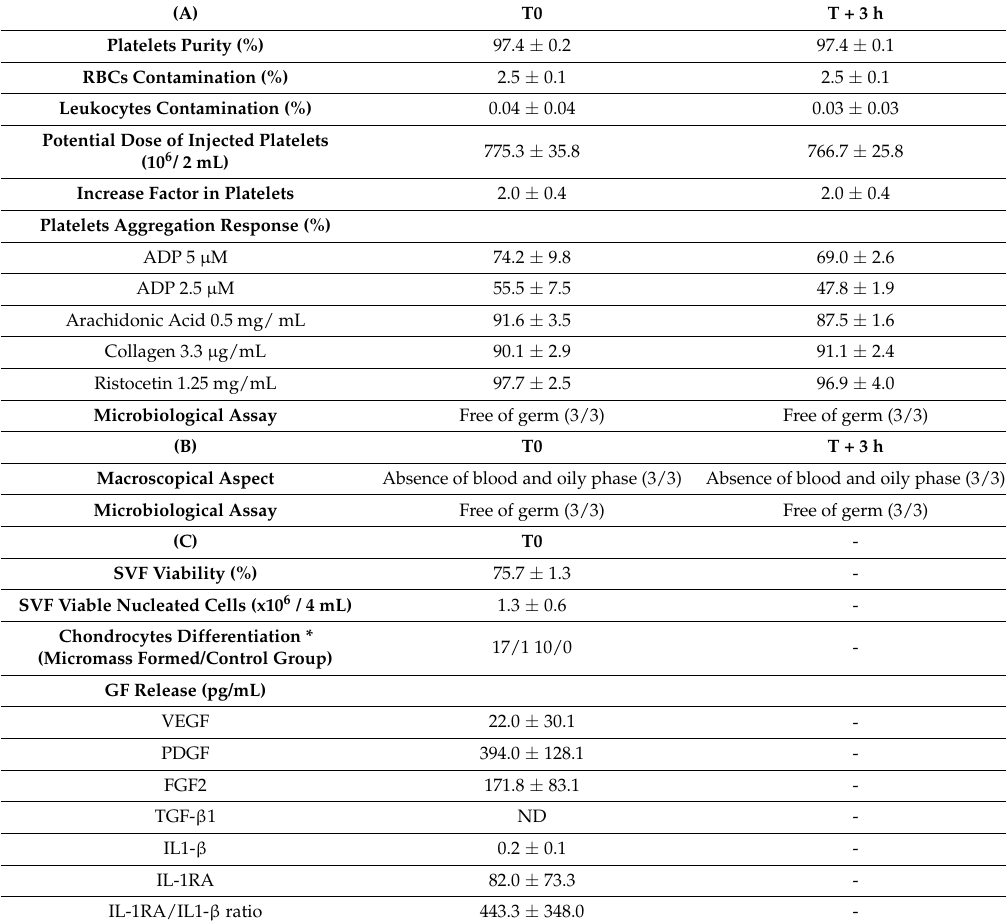
Table 1. Biological characteristics of PRP (A), microfat (B), and PRP mixed-microfat (C) obtained from the analysis of GMP compliant process validation